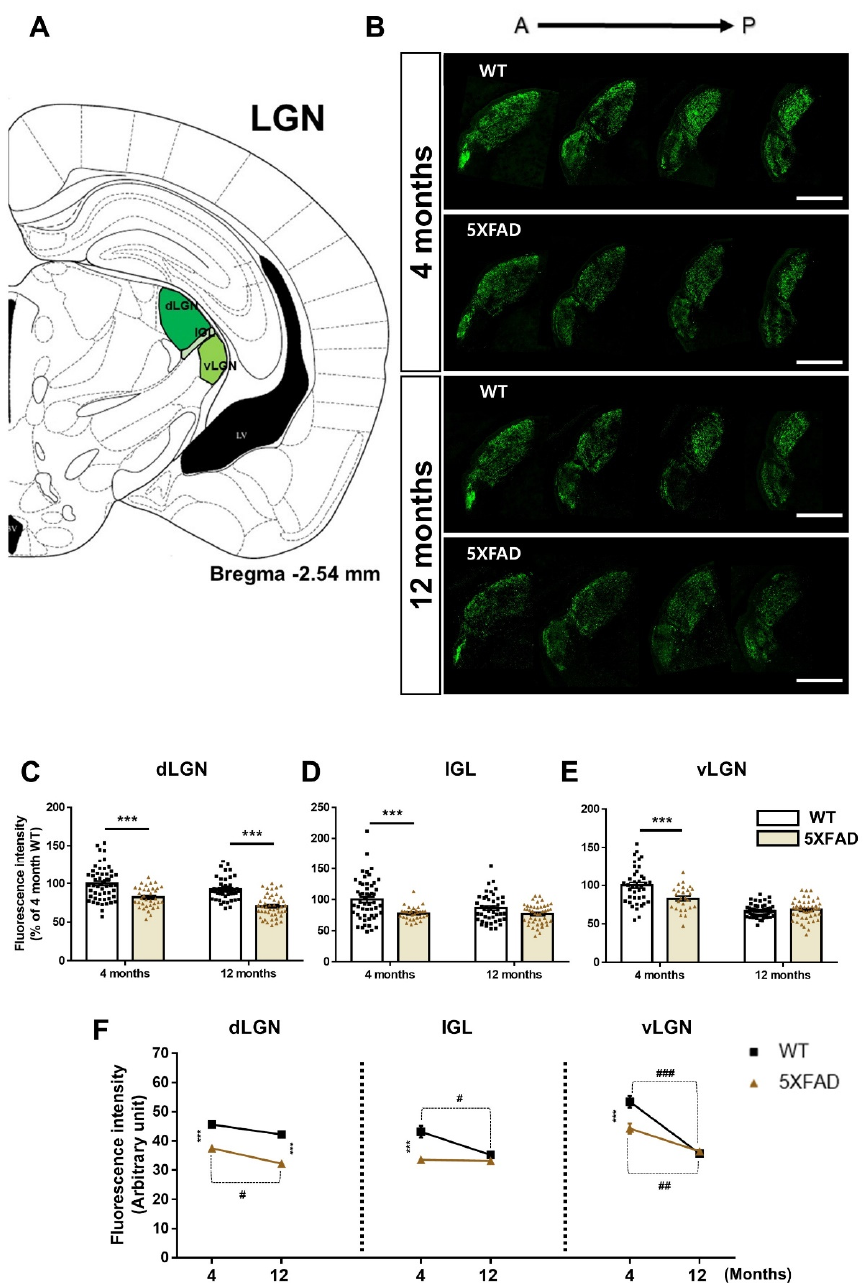
Figure 5. Changes of the retina-lateral geniculate nucleus (LGN) connections in WT and 5XFAD mice. ( A ) Image of a mouse brain atlas exhibiting the location of the LGN. ( B ) The representative images show CT β transported from the retina to the LGN. Scale bar = 500 μ m. The quantitative graphs exhibit the fluorescence intensity of CT β (+) areas in the ( C ) dorsal lateral geniculate nucleus (dLGN), ( D ) intergeniculate leaflet (IGL), and the ( E ) ventral lateral geniculate nucleus (vLGN) of WT and 5XFAD mice (31 − 53 images of the brain sections were obtained from 5 mice in each group). ( F ) Comparison of the impairment of the retina-LGN pathways by aging and AD progression. Sta- tistical analysis was conducted by two-way ANOVA, followed by Tukey’s post hoc test. *** p < 0.001, # p < 0.05, ## p < 0.01, and ### p < 0.001 indicate a significant difference.